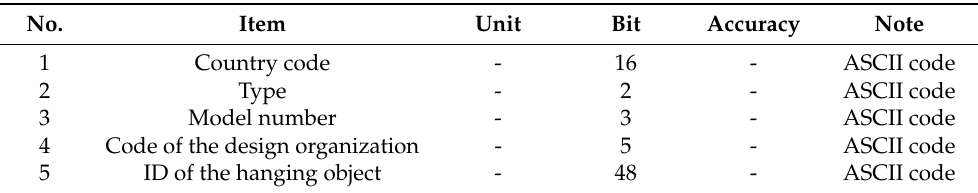
Table 5. Description of the pod.